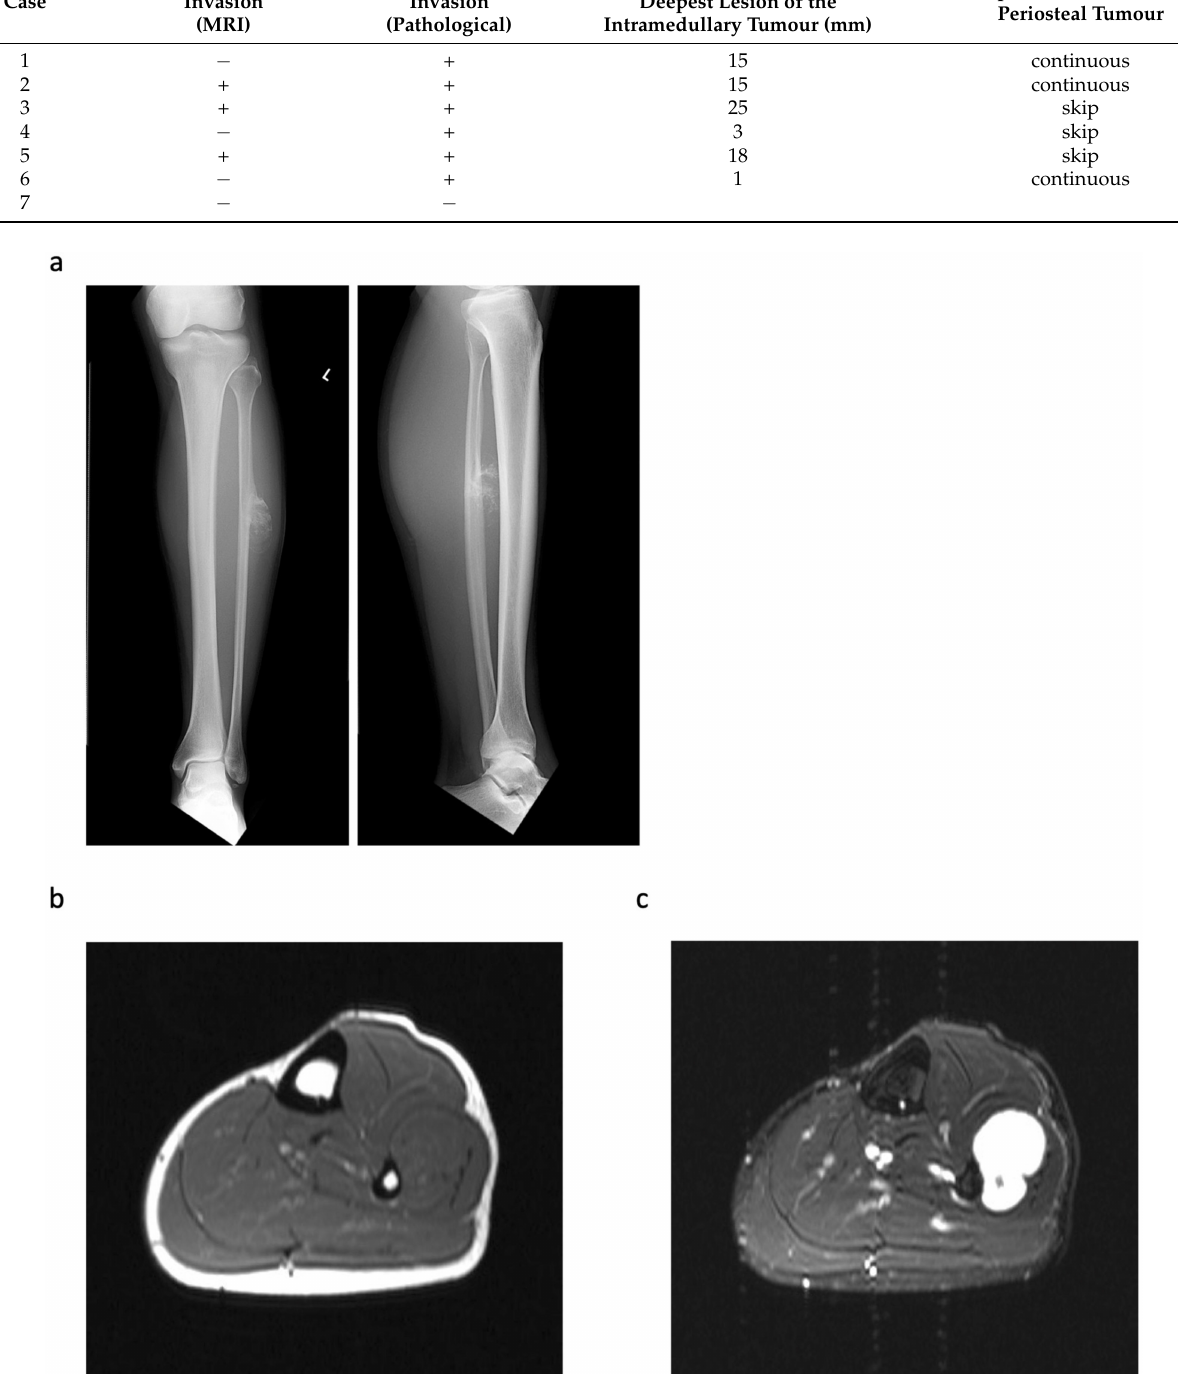
Figure 3. A 37-year-old male with a pathological diagnosis of periosteal chondrosarcoma (Case 4). ( a ) Radiograph of the left leg showing a lobulated calcified mass on the anterior aspect of the diaphysis of the fibula. The cortex is eroded. ( b ) T1-weighted MRI showing a lobulated mass (5.5 × 2.5 × 3.5 cm), with low signal intensity, arising from the periosteum. ( c ) T2-weighted fat suppressed MRI showing a predominantly high signal intensity mass. Neither medullary invasion nor adjacent soft tissue oedema are